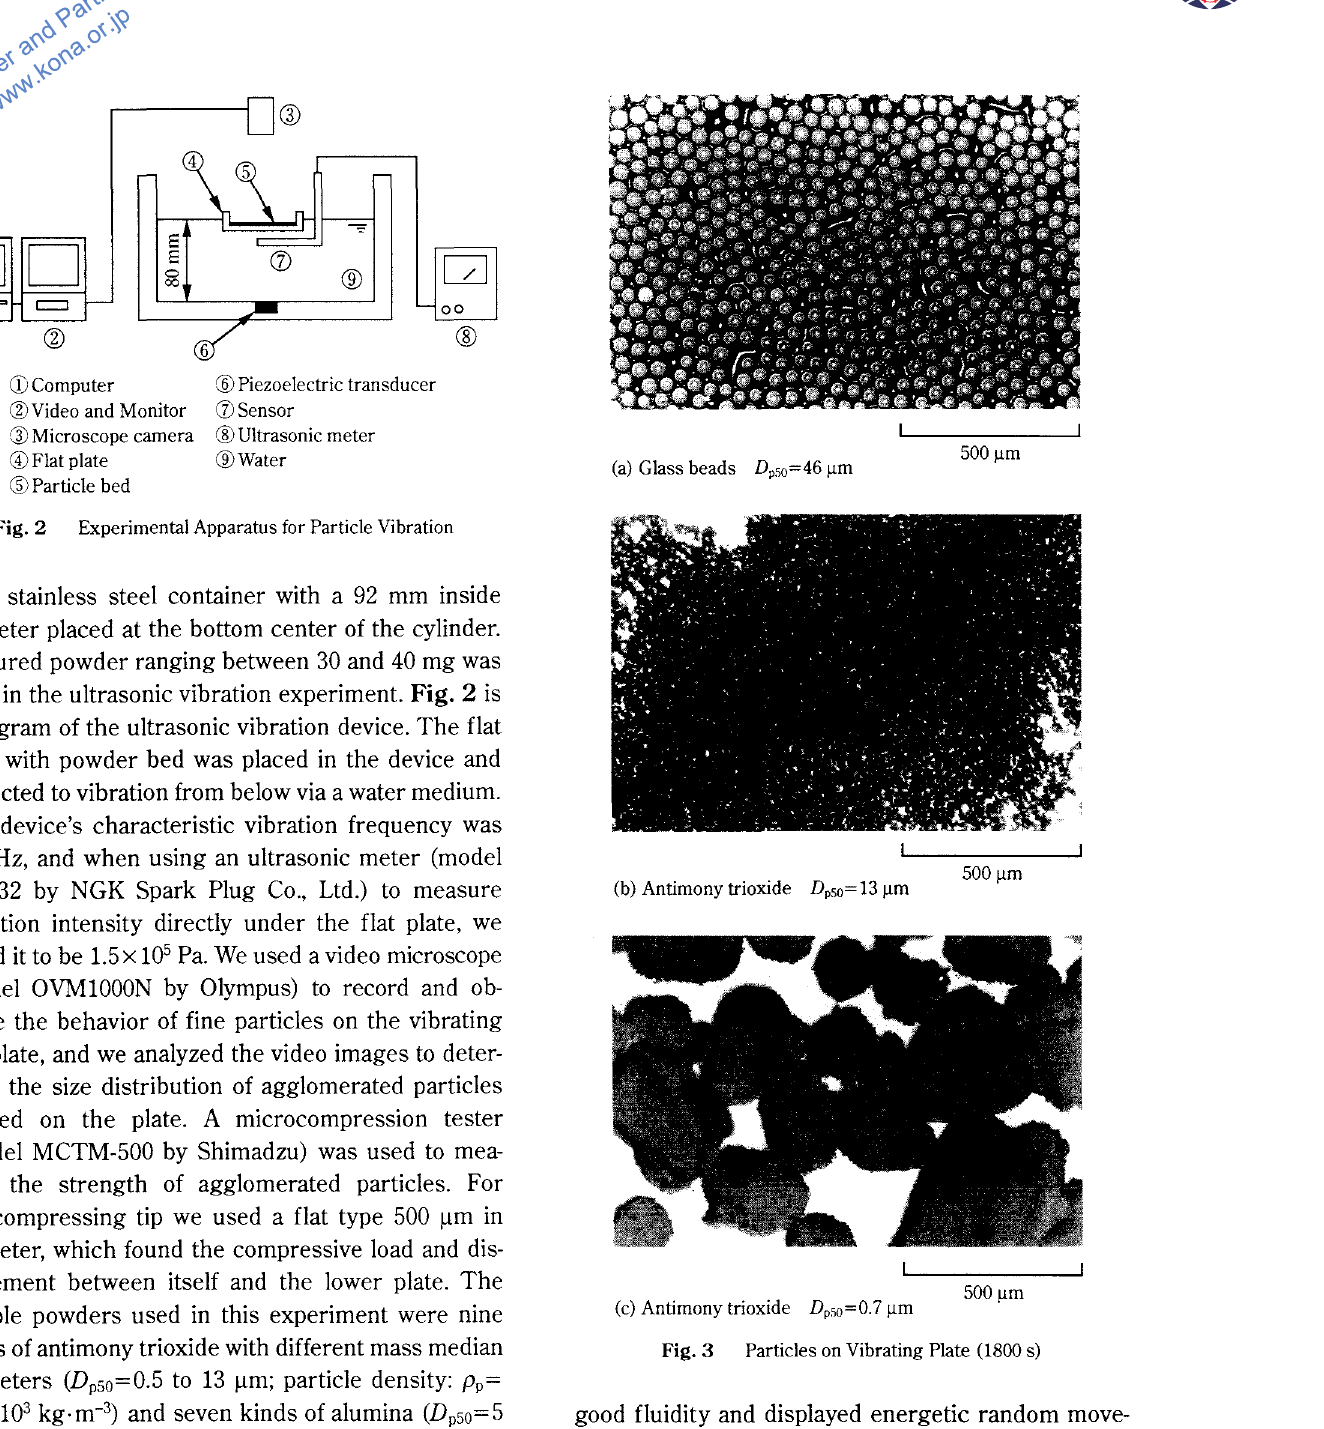
Fig. 3 Particles on Vibrating Plate (1800 s) good fluidity and displayed energetic random move ment on the stainless steel plate. Photo (a) shows the result after affixing a film of polymer to the plate as a vibration damper. It is evident from the photograph that by adjusting vibration intensity it is possible to make a uniform particle bed. On the other hand, anti mony trioxide (Dpso= 13 ~-tm) was formed into agglom erates of several tens of ~-tm that covered the plate like a film (Fig. 3 (b), particles look black), while the fine particles (Dpso=0.7 ~-tm) formed comparatively large agglomerates measuring several hundred ~-tm (Fig. 3